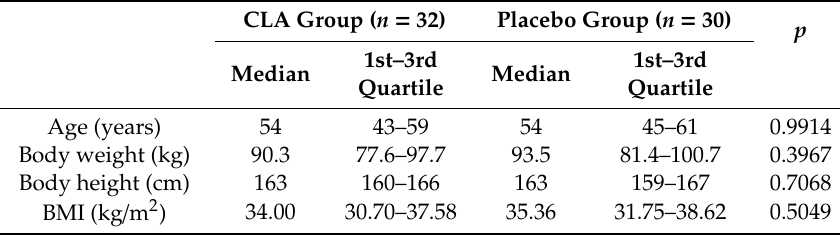
Table 1. Baseline characteristics of the study